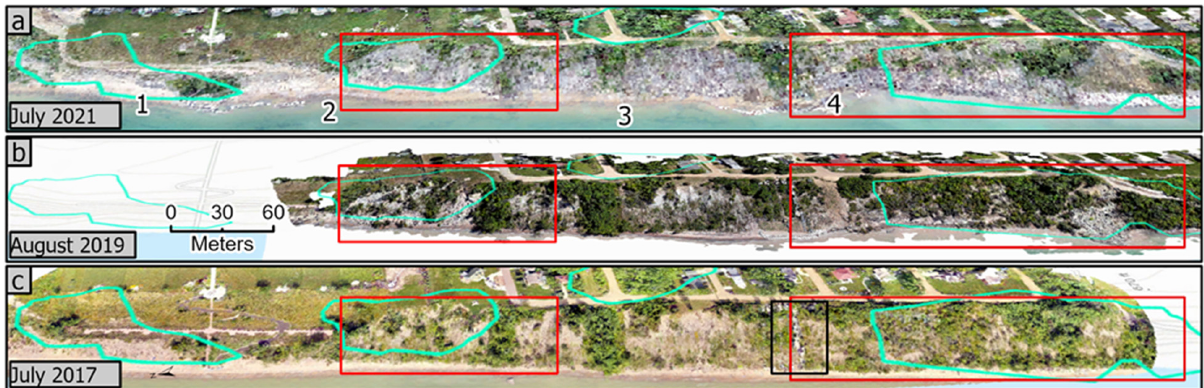
Figure 8. UAV orthomosaic images acquired in the summers of 2021 ( a ), 2019 ( b ), and 2017 ( c ) over the study area draped over a DEM. The figure shows progressive landcover change along the bluff. Also shown are the outlines of the area covered by anomalies 1, 2, 3, and 4 (green polygons), and the areas shown in Figures 9 (red boxes) and 10b (black box).